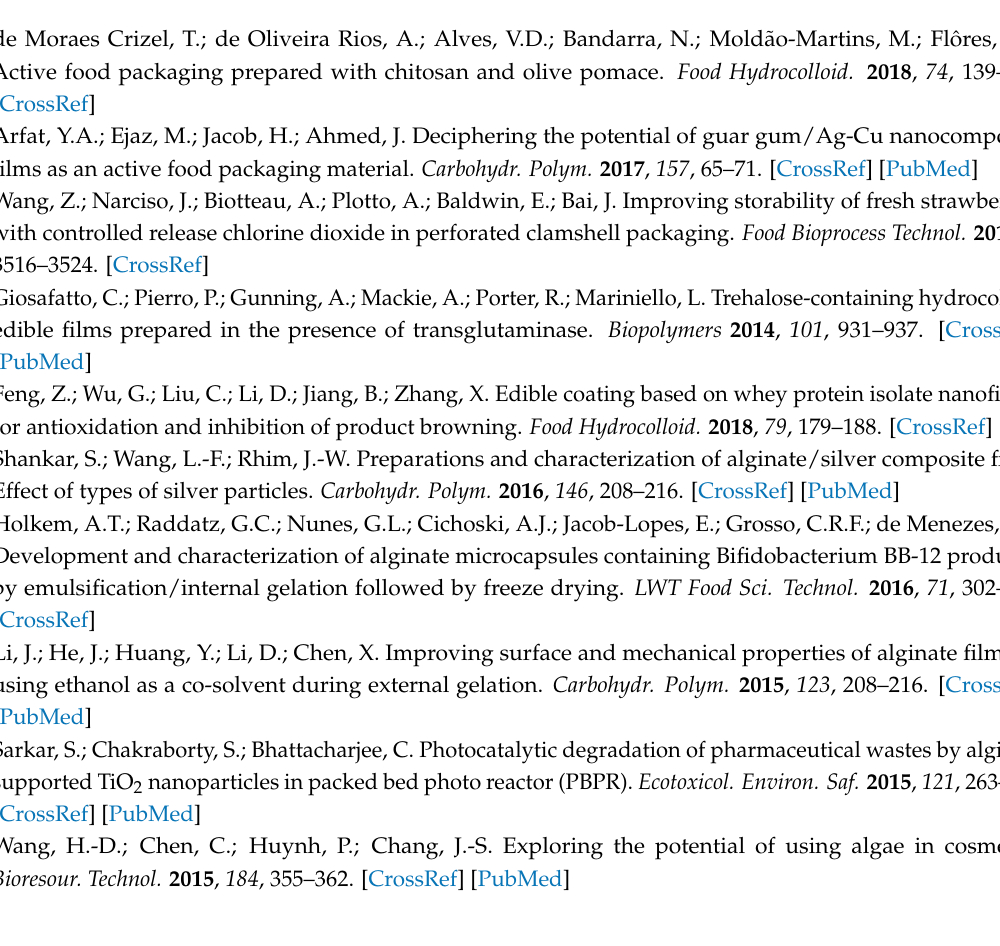
Figure S1: Zeta potentials of Au nanoparticles, TiO 2 nanoparticles, and Au-TiO 2